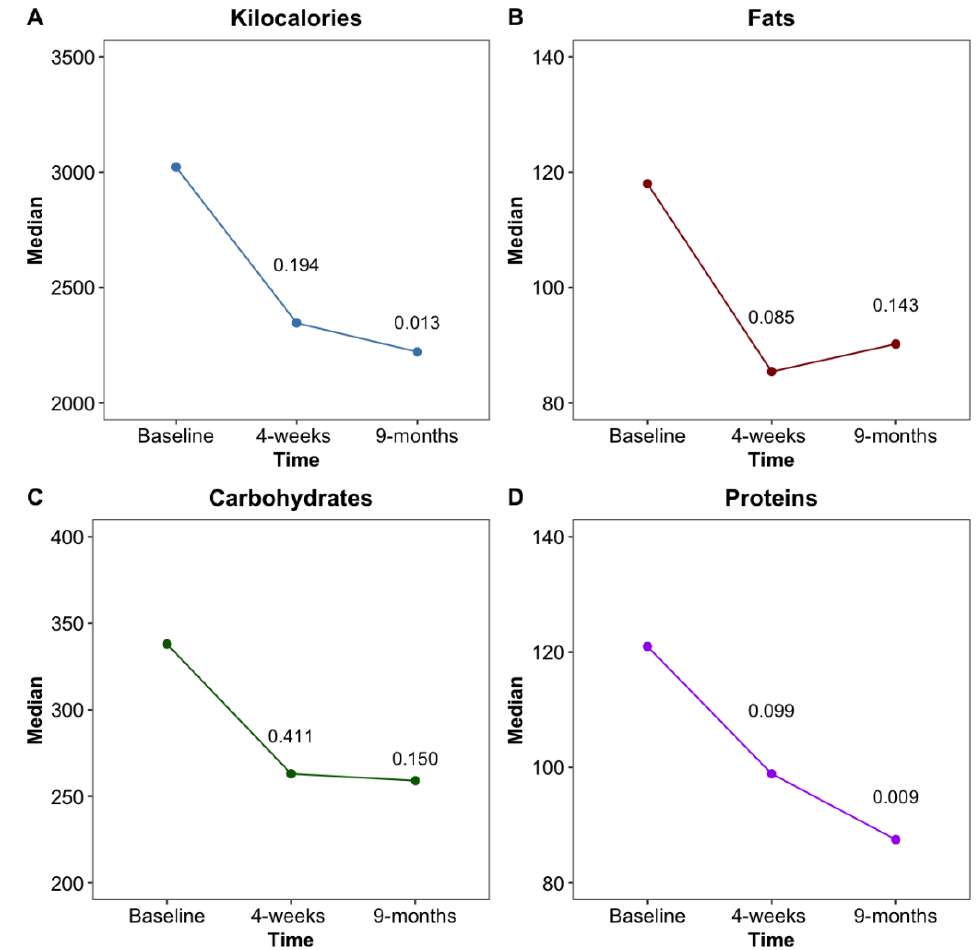
Figure 2. Changes of total kcal ( A ), as well as fat ( B ), carbohydrate ( C ) and protein ( D ) intake in grams at baseline, 4 weeks and 36 weeks after EndoBarrier™ implantation.